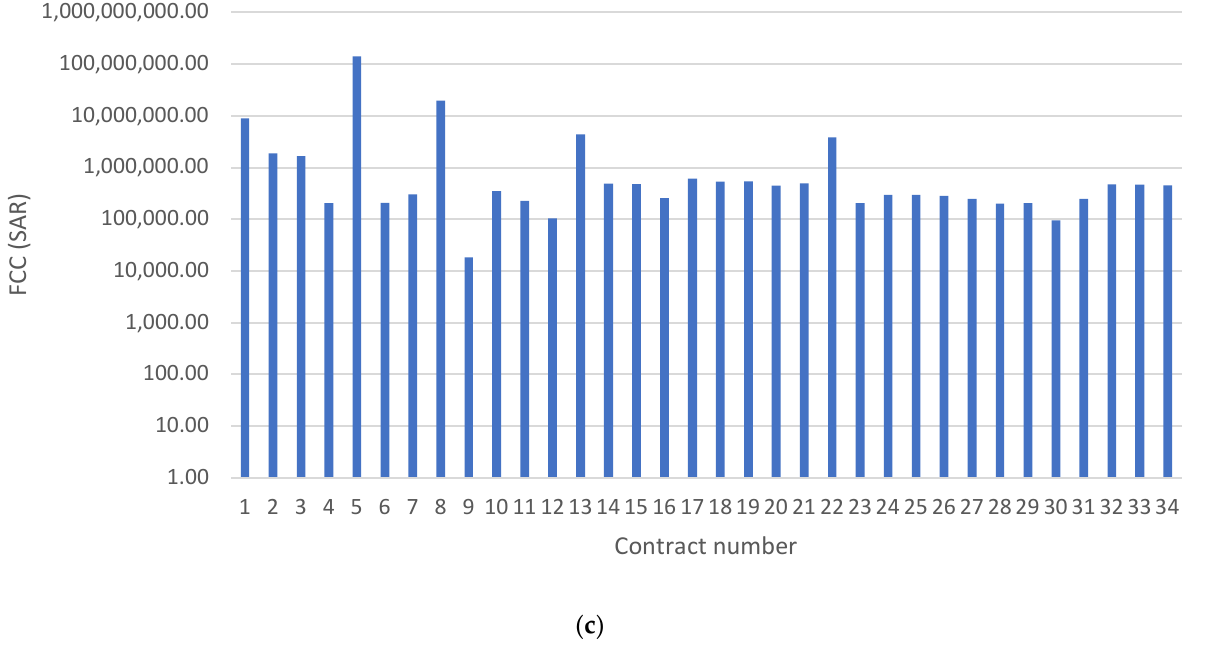
Figure 4. The 3 costs in the 34 projects: ( a ) owner’s estimate cost ( OCE ), ( b ) contract cost ( CC ), and ( c ) final contract cost ( FCC ).